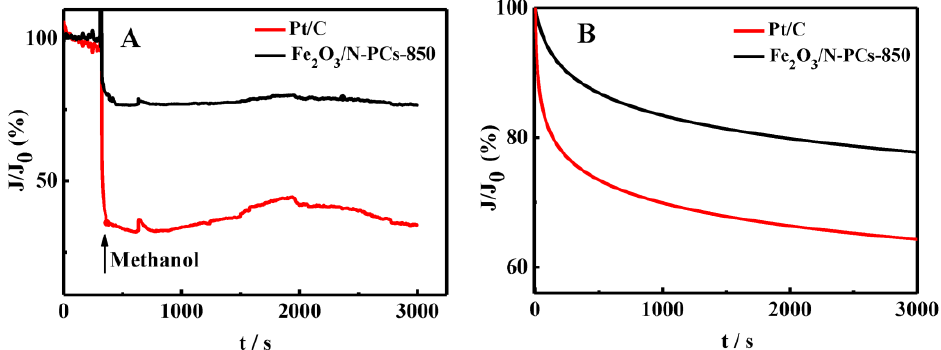
Figure 8. ( A ) I-t responses at the Pt/C (20%) and Fe 2 O 3 /N-PCs-850 at −0.2 V in O 2 -saturated 0.1 M KOH. The arrow refers to the introduction of 3.0 M methanol; ( B ) I-t responses of Fe 2 O 3 /N-PCs-850 and 20% Pt/C at −0.3 V in the O 2 -saturated 0.1 M